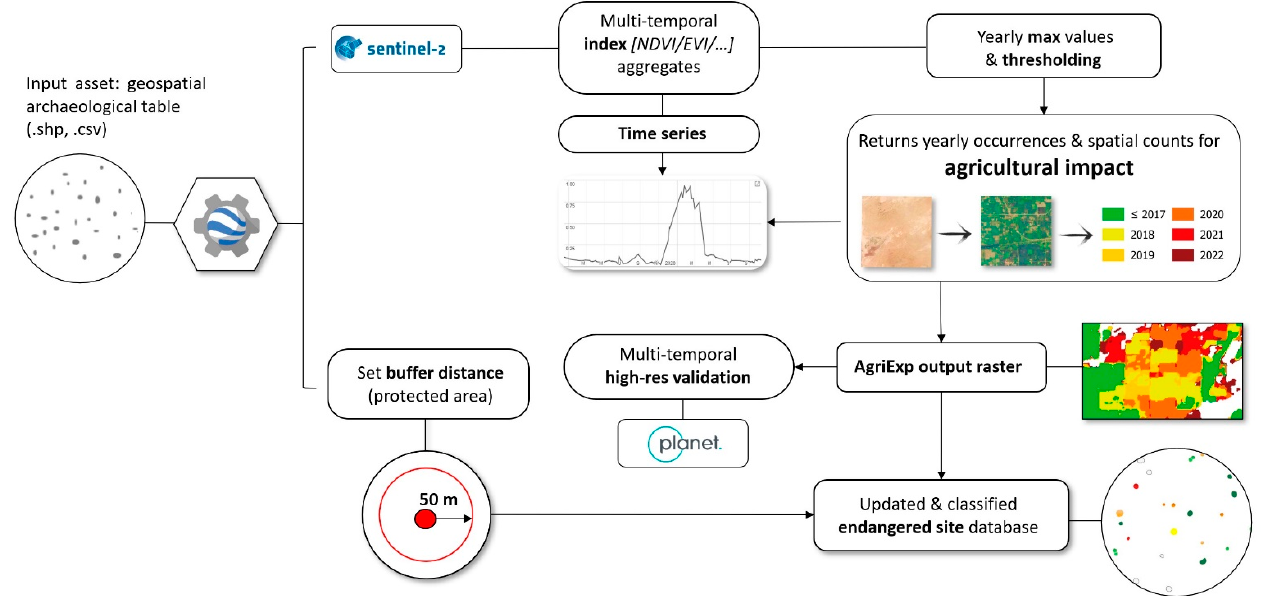
Figure 2. AgriExp’s workflow